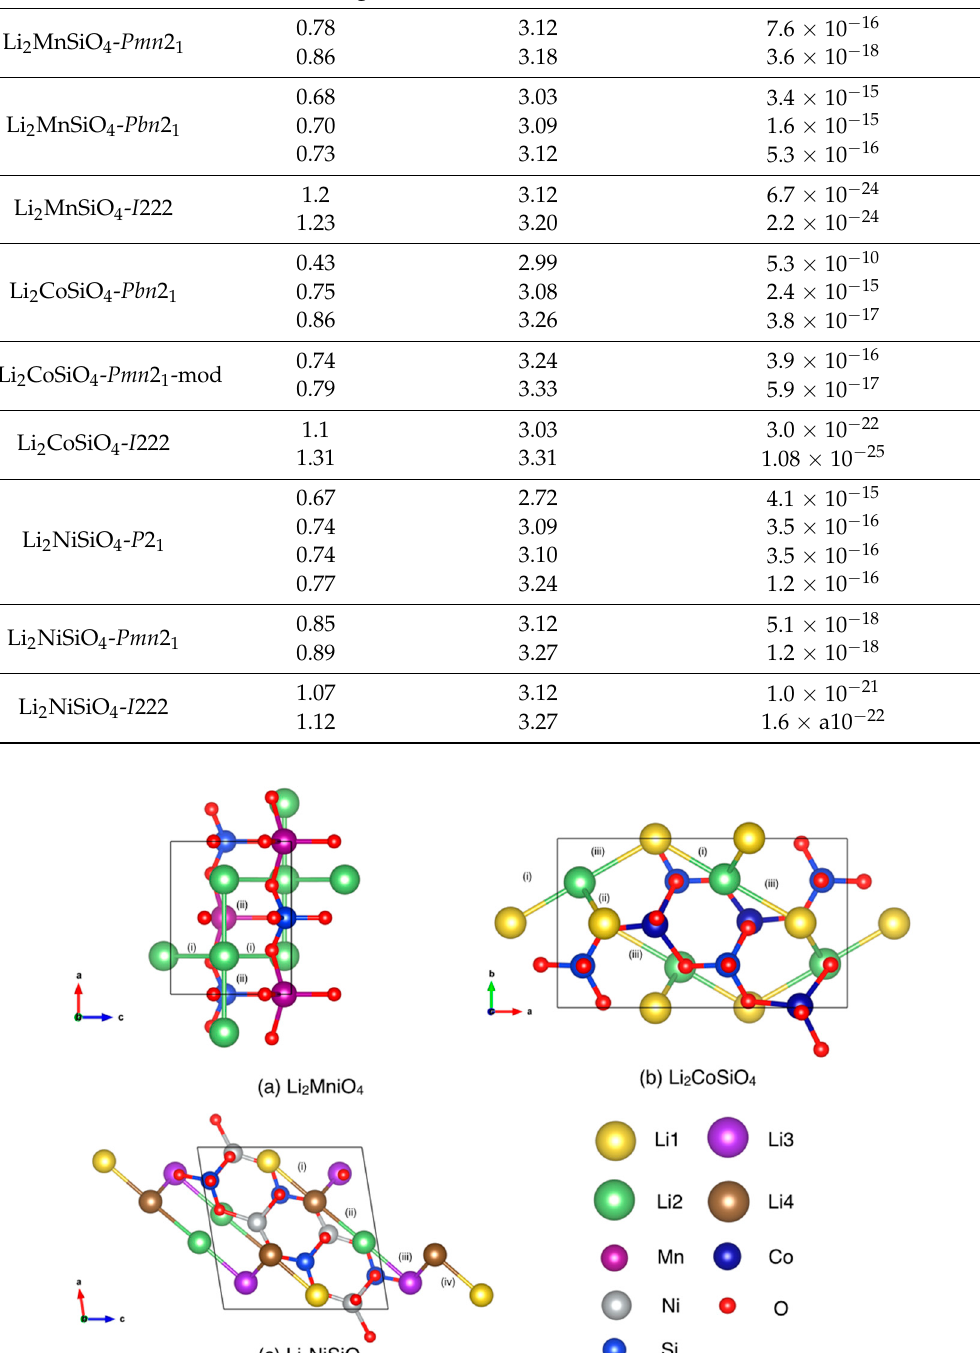
Table 5. Calculated barrier height (in eV), Li ‐ Li migration distance (in Å), and diffusion coefficient (D; cm 2 s − 1 ) for Li 2 M SiO 4 phases.